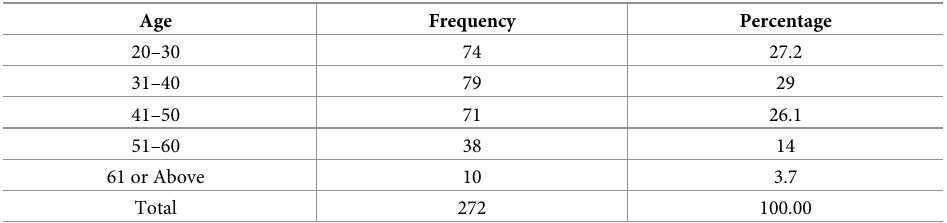
Table 3. Age frequency (N =